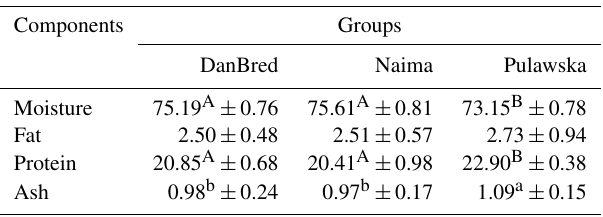
Table 2. Chemical properties of the longissimus lumborum muscle in pigs (100gkg − 1 ).